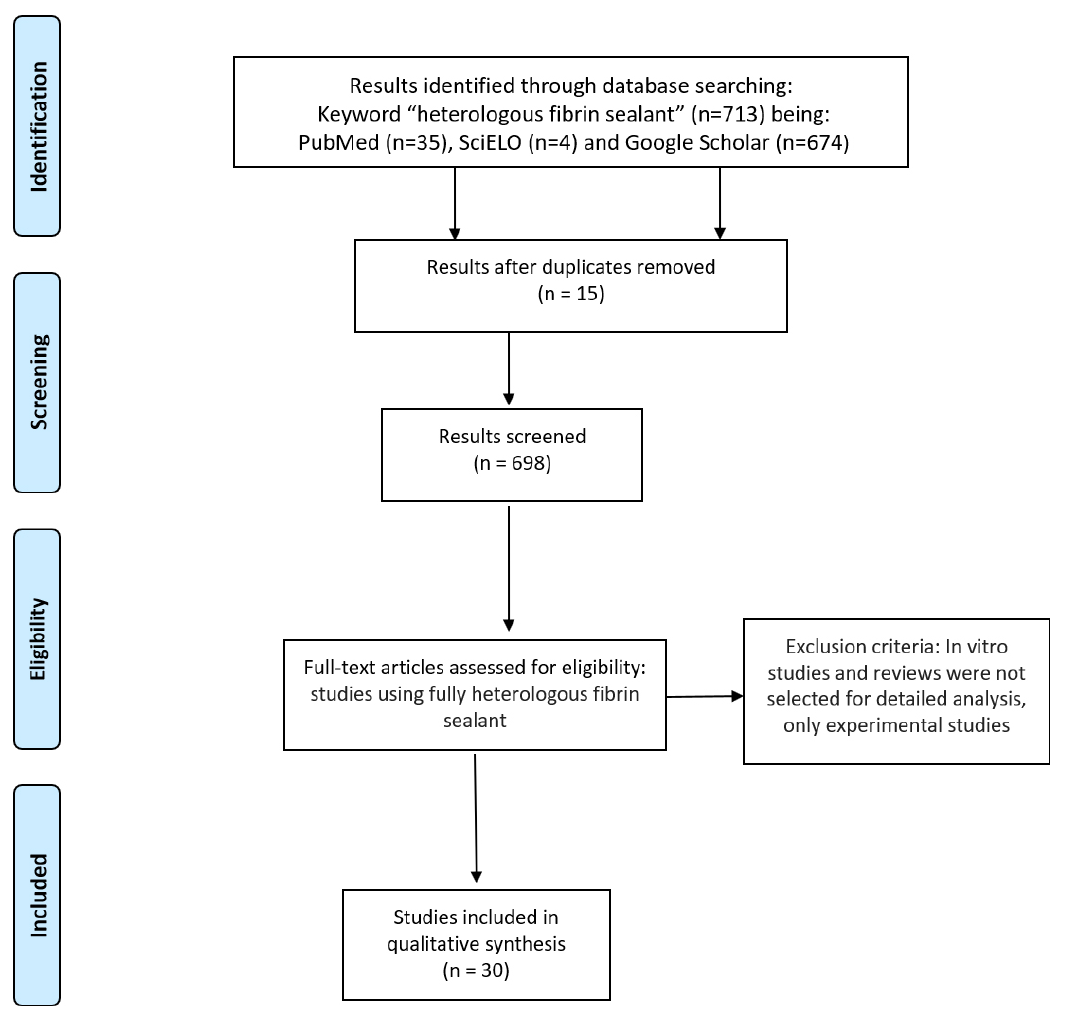
Figure 1. Flowchart of search strategy to identify eligible